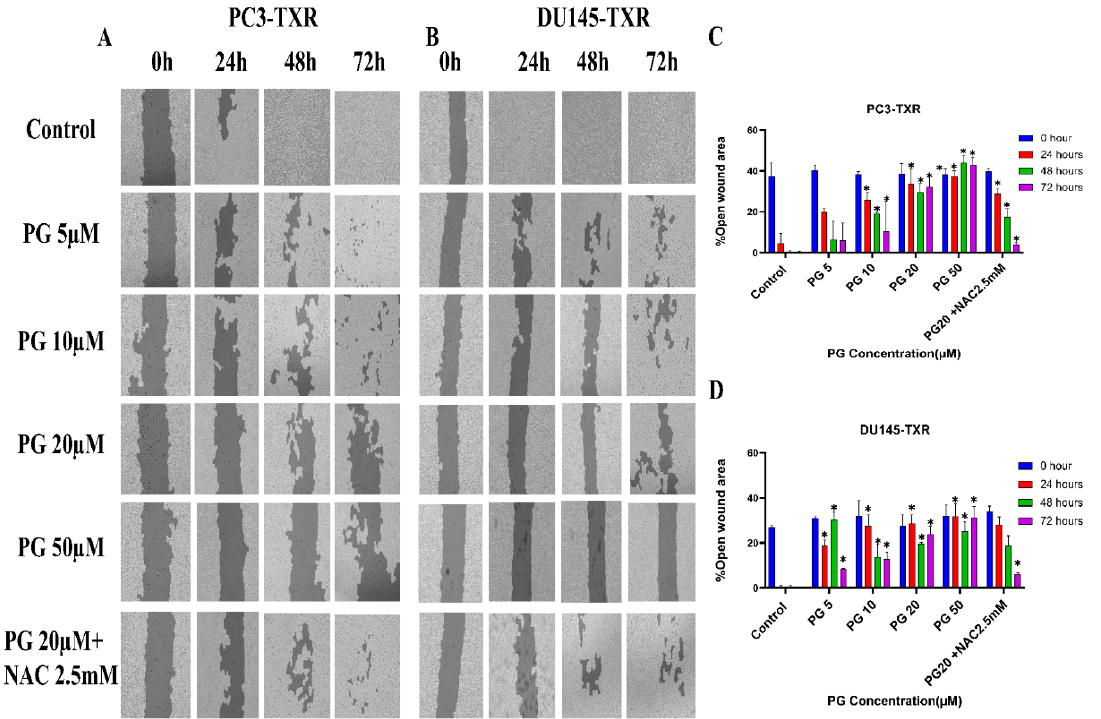
Figure 4. PG inhibits cell migration in taxane-resistant PCa cell lines. ( A ) PC3-TXR and ( B ) DU145- TXR cell line images were taken at 0, 24, 48, and 72 h and analyzed using T-scratch software. ( C ) and ( D ) represent the % open area plotted against varying concentrations of PG for PC3-TXR and DU145-TXR. Images were taken at 10X magnification. Data are represented as mean ± SD ( n = 3), and three independent trials were conducted in triplicate. * p < 0.05.